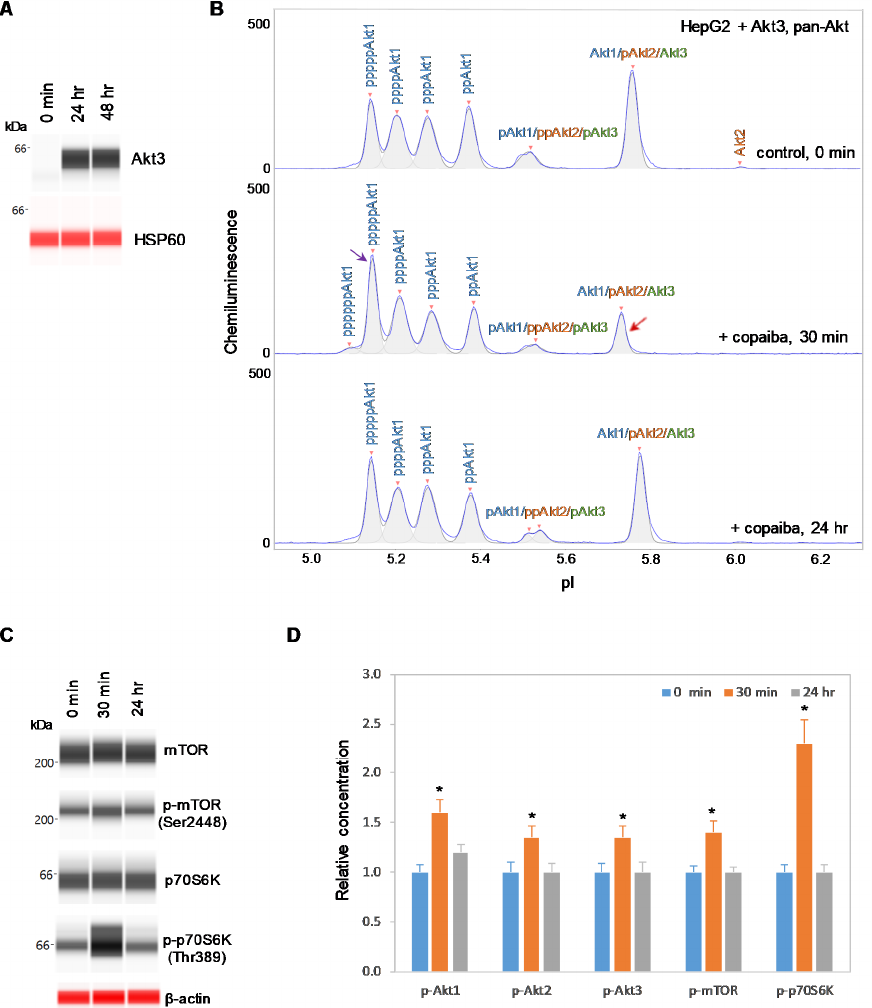
Figure 6. Expression of Akt3 in HepG2 cells promotes positive regulation of the pI3K / Akt / mTOR signaling pathway by copaiba essential oil. ( A ) Expression of Akt3 from plasmid DNA in HepG2 cells before (0 min) and after (24 h and 48 h) transfection with Akt3-encoding plasmid DNA. HSP60 served as the loading control. ( B ) cIEF electropherograms of pan-Akt in HepG2 cells transfected with Akt3-encoding plasmid DNA for 24 h as a function of time after treatment with copaiba essential oil. Peaks associated with Akt isoforms are labeled and color-coded: Akt1 (blue), Akt2 (orange), and Akt3 (green). The purple arrow points to the highly phosphorylated Akt1 peak that transiently increased following treatment with copaiba essential oil. Note the relative intensity of this peak compared to that of other peaks in the cIEF electropherogram. The red arrow points to the transient reduction in the relative intensity of a peak comprising the least-modified isoforms of Akt1, Akt2, and Akt3. ( C ) Expression levels of the mTOR and p70S6K phosphoisoforms as a function of time after treatment with copaiba essential oil. β -Actin served as the loading control. ( D ) Relative concentrations of Akt1, Akt2, Akt3, mTOR, and p70S6K phosphoisoforms as a function of time after treatment with copaiba essential oil. The relative concentration describes the fold change in the expression level of a protein phosphoisoform after treatment compared to that under the control condition. The error bars indicate the standard deviations of six repeated measurements per experimental condition. The asterisks indicate a statistical significance of p ≤ 0.05 versus the control. HepG2 cells were treated with 100 ng / mL copaiba essential